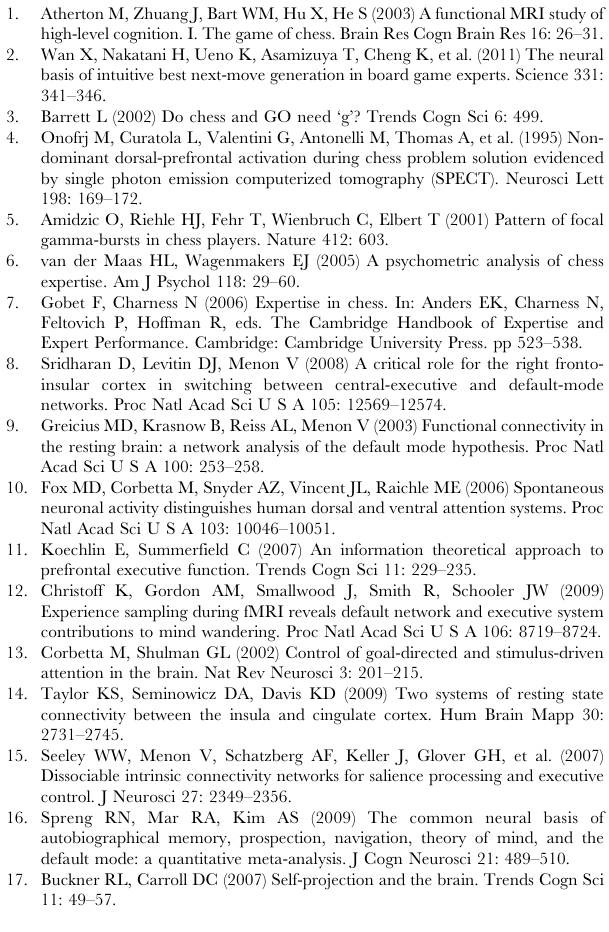
the PCC and left AG of the DMN when contrast Game condition to Random condition (Two sample t -test, p , 0.05, corrected for multiple comparison). Table S1 Coordinates of CEN, DAN, SN and DMN activation and deactivation during Chinese chess problem-solving task (Game condition vs. Random condition) ( p , 0.05, corrected for multiple comparison). Table S2 Deactivation differences in the DMN during Chinese chess problem-solving task (Game condition vs. Random condi- tion) ( p , 0.05, corrected for multiple